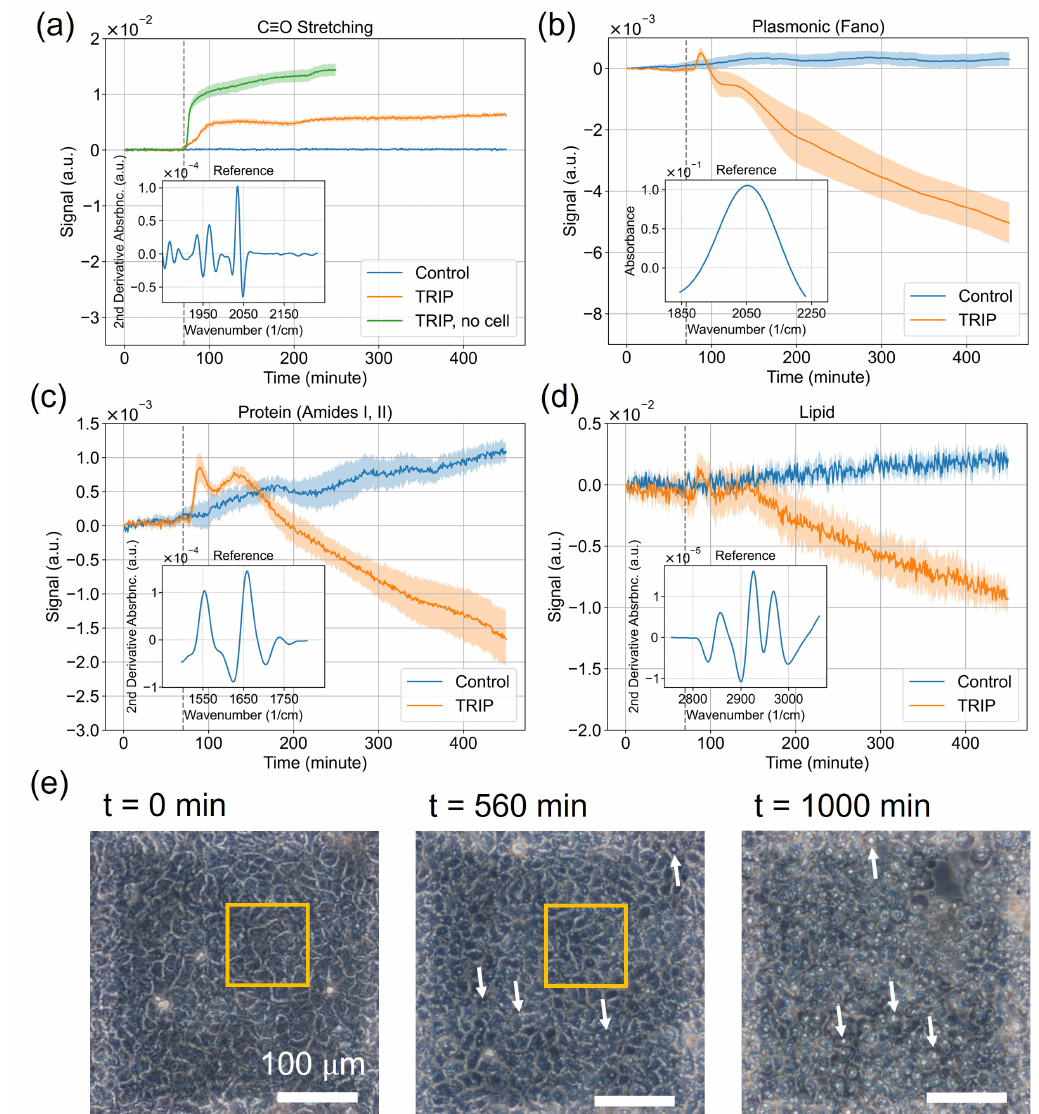
Figure 4. Time-dependent MEIRS signals of A431 cells under drug treatment with TRIP ( C TRIP = 5.0 µ M) for the four spectral windows: bioorthogonal ( a ) and cell-related ( b – d ). Insets: reference spectra used for linear regression. Blue (orange) solid curves: control (drug-treated) cell responses S ( t ) representing the mean of five replicates. Shaded regions: standard errors. Green curve in ( a ): IR-tag signal of TRIP without cells. Drug arrival times are shifted to t 0 = 70 min (vertical dashed line). ( a ) S C ≡ O ( t ) for the intrinsic IR-tag signal of the TRIP compound. Inset: L ( 2 ) IR − tag ( ω ) , = 1928 cm − 1 , ω C ≡ O = 1967 cm − 1 , and ω C ≡ O = 2031 cm − 1 . ( b ) S pl ( t ) for the with peaks at ω C ≡ O 2 3 1 plasmonic resonance shift signal. Inset: L ( 0 ) pl ( ω ) CRR spectrum for the plasmonic spectral window (1845 < ω < 2231 cm − 1 ). ( c ) S prot ( t ) for the protein signal. Inset: L ( 2 ) prot ( ω ) CRR spectrum for the protein spectral window (1498 < ω < 1807 cm − 1 ). ( d ) S lip ( t ) for the lipid signal. Inset: L ( 2 ) lip ( ω ) CRR spectrum for the lipids spectral window (2756 < ω < 3064 cm − 1 ). Note that the signs of the second derivative reference spectra are flipped for more intuitive presentation. ( e ) The phase contrast microscopy images of A431 cells before, after t = 560 min, and after t = 1000 min TRIP treatment. White arrows: the cytoplasmic vacuoles as the signs of apoptosis. Yellow squares: marking of the same area to identify cell shrinkage after TRIP treatment. Shaded areas: 300 × 300 µ m 2